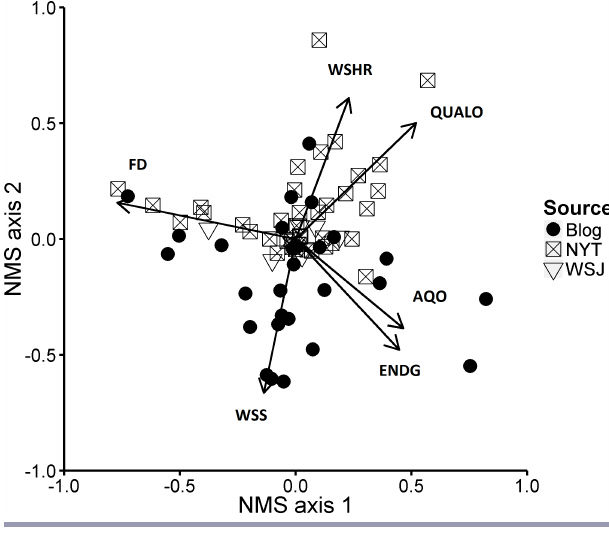
Fig. 5 . Nonmetric Multidimensional Scaling plot for Attributes, see Appendix 1 for long form code descriptions.